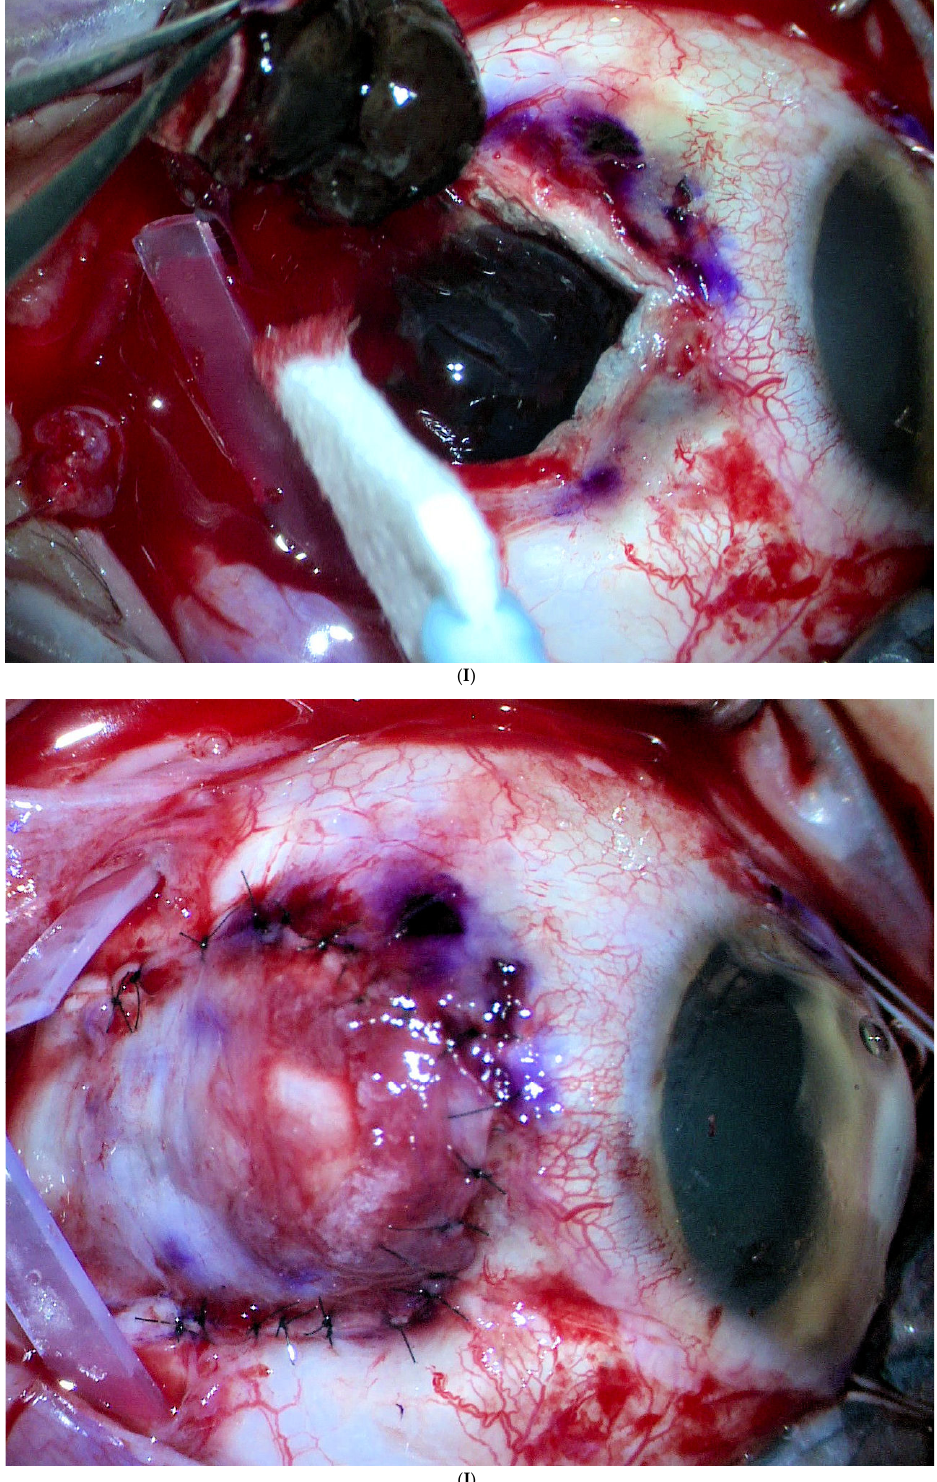
Figure 1. Ab externo scleral resection technique. ( A ). The medial rectus is disinserted to leave the sclera exposed. ( B ). Transillumination and marking of the edges of the tumour base. ( C ). Scleral incision in a polyhedral shape, around the base of the tumour and with 2 mm margins. ( D , E ). Scleral flap dissection with a straight scalpel. Further marking of the tumour base by transillumination. ( F , G ). Complete section of the inner sclera and exposed uvea around the tumour base with curved and blunt scissors. ( H , I ). Careful release of the mushroom-shaped tumour, meticulously separating it from the retina. ( J ). Complete and tight closure of the coloboma with the external scleral flap.